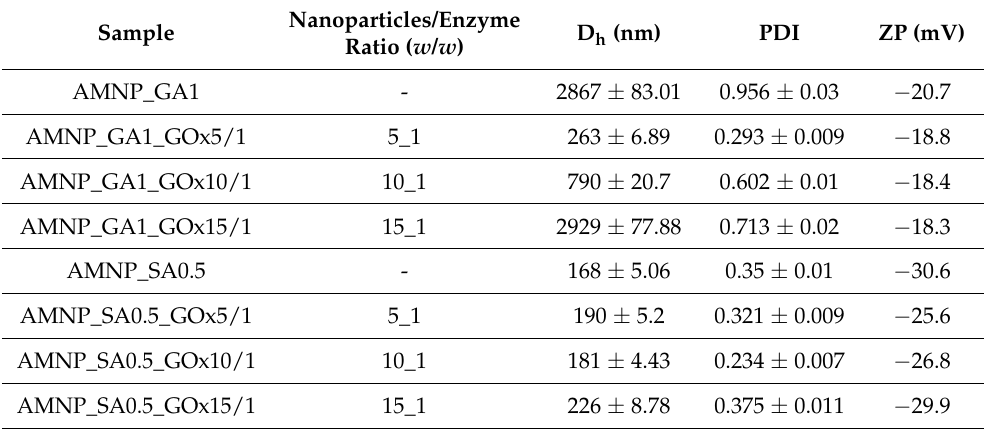
Table 2. Characteristics obtained in the DLS measurements for AMNP_GA/SA conjugated with GOx depending on the nanoparticle/enzyme ratio in buffer solution with pH